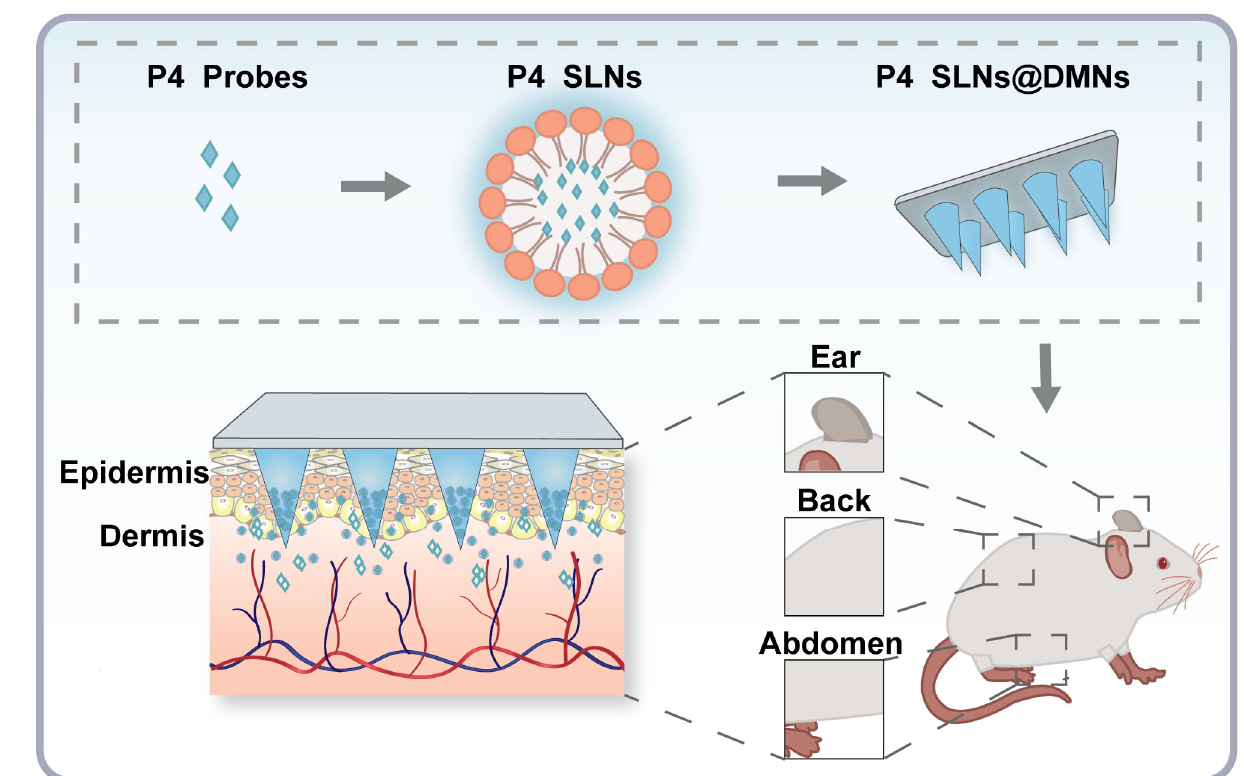
Figure 1. Schematic illustration of the research framework: Impact of different skin sites on in vivo fate of P4 SLNs@DMNs. fate of P4